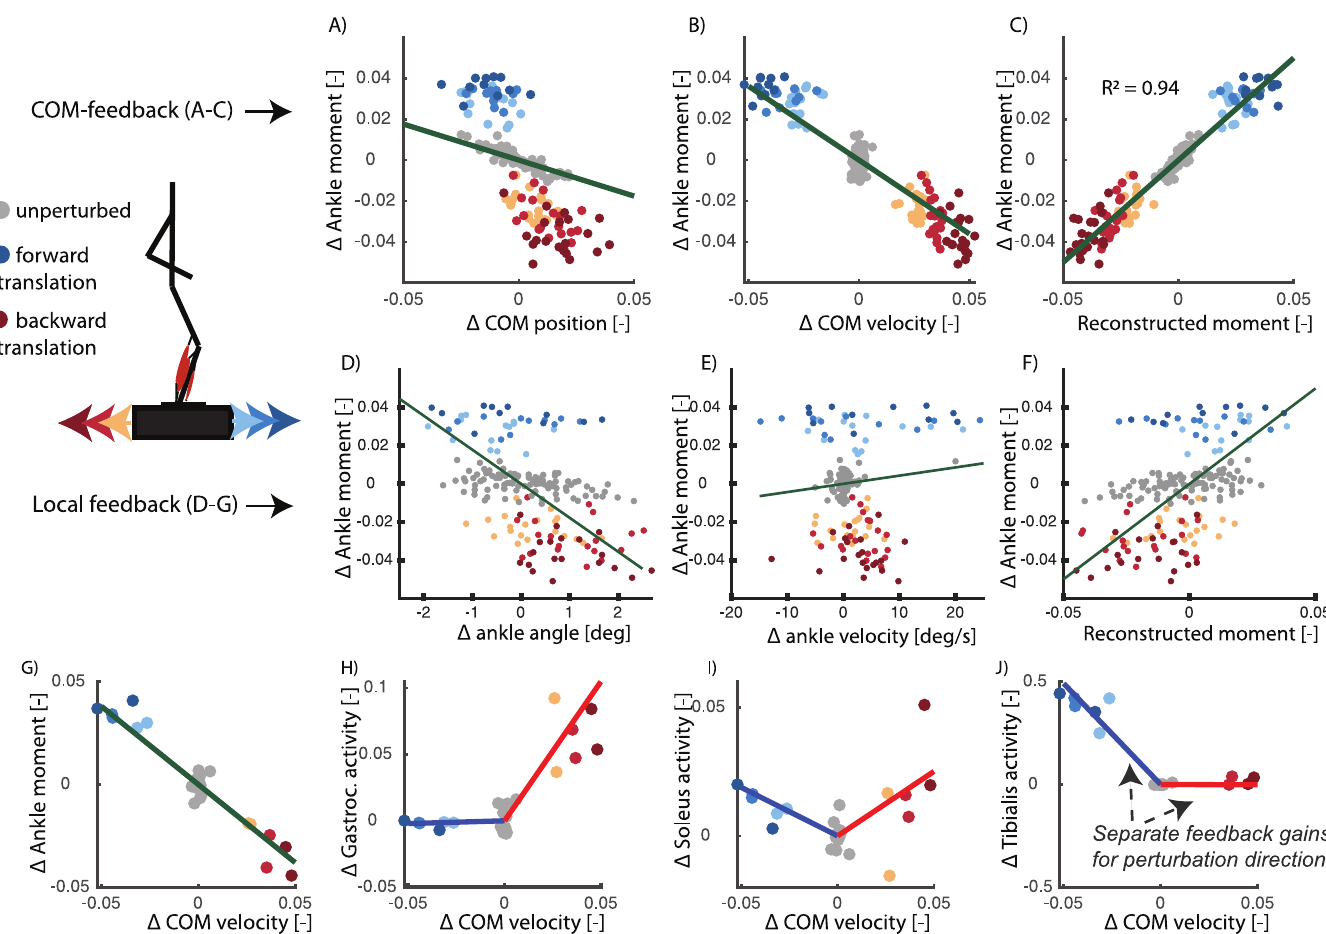
Fig 3. Perturbed standing (data from [26]). Here we show the relation between COM kinematics and ankle moment (A-C) and the relation between ankle kinematics and ankle moment (D-F) 150ms after perturbation onset. Each dot represents a single perturbation trial with a platform translation in forward (blue) or backward (red) direction with different magnitudes (color tint). A feedback model based on delayed COM position (A) and velocity (B) feedback can explain 94% of the variance in ankle moment (C) in response to support surface translations in forward and backward directions of different magnitudes. The linear feedback model based on angle angle (D) and angular velocity (E) explained only 21% of the variance in ankle moment (F). When analysing the data for each subject individually in the COM feedback model (G-J), we found that gastrocnemius and soleus activity increased with forward COM velocity and tibialis anterior activity increased with backward COM velocity. Each dot in graphs (G-J) represents a single perturbation trial of a selected subject. Note that the electromyography data was analysed for individual subjects instead of pooled over all subjects due to the limitations related to normalizing electromyography data.